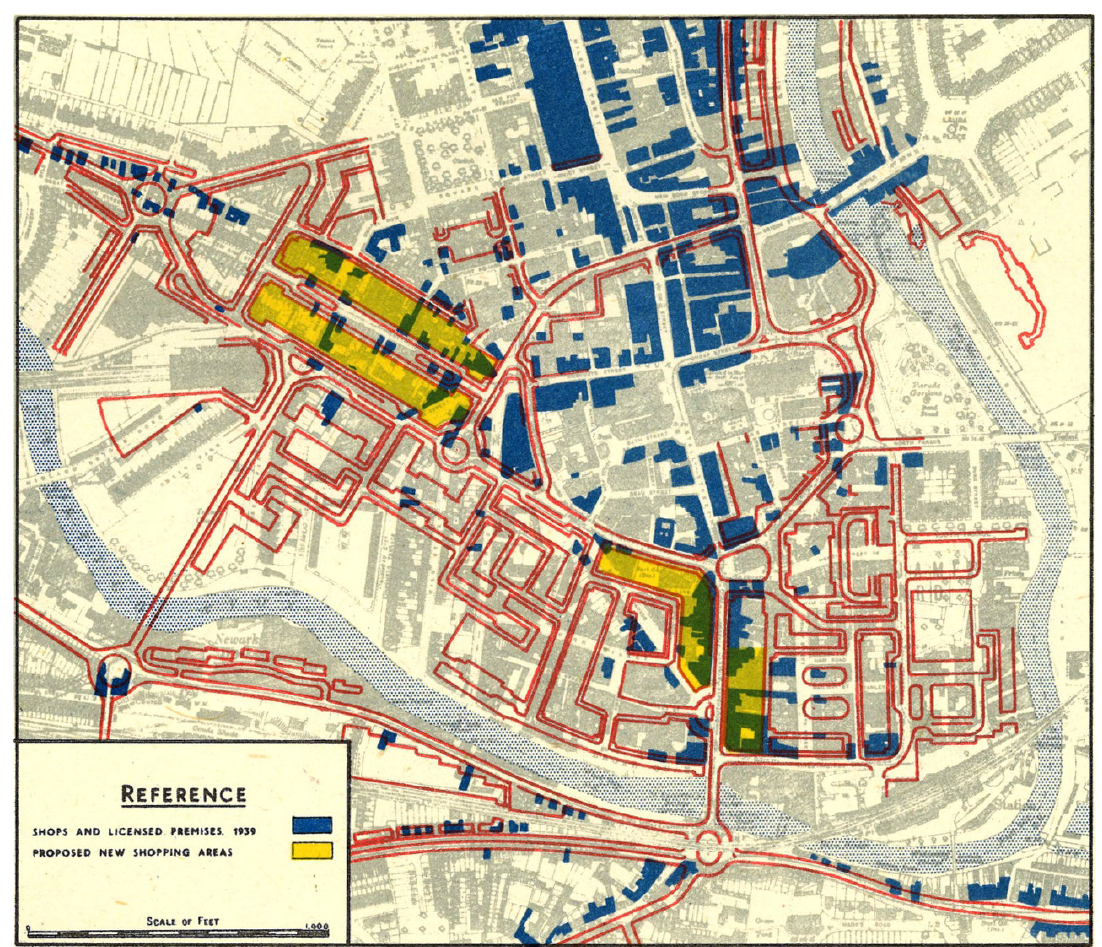
Figure 3. Redevelopment proposals focusing on the worn‐out and bombed areas south of the city core. Source: Abercrombie et al. (1945, following p.